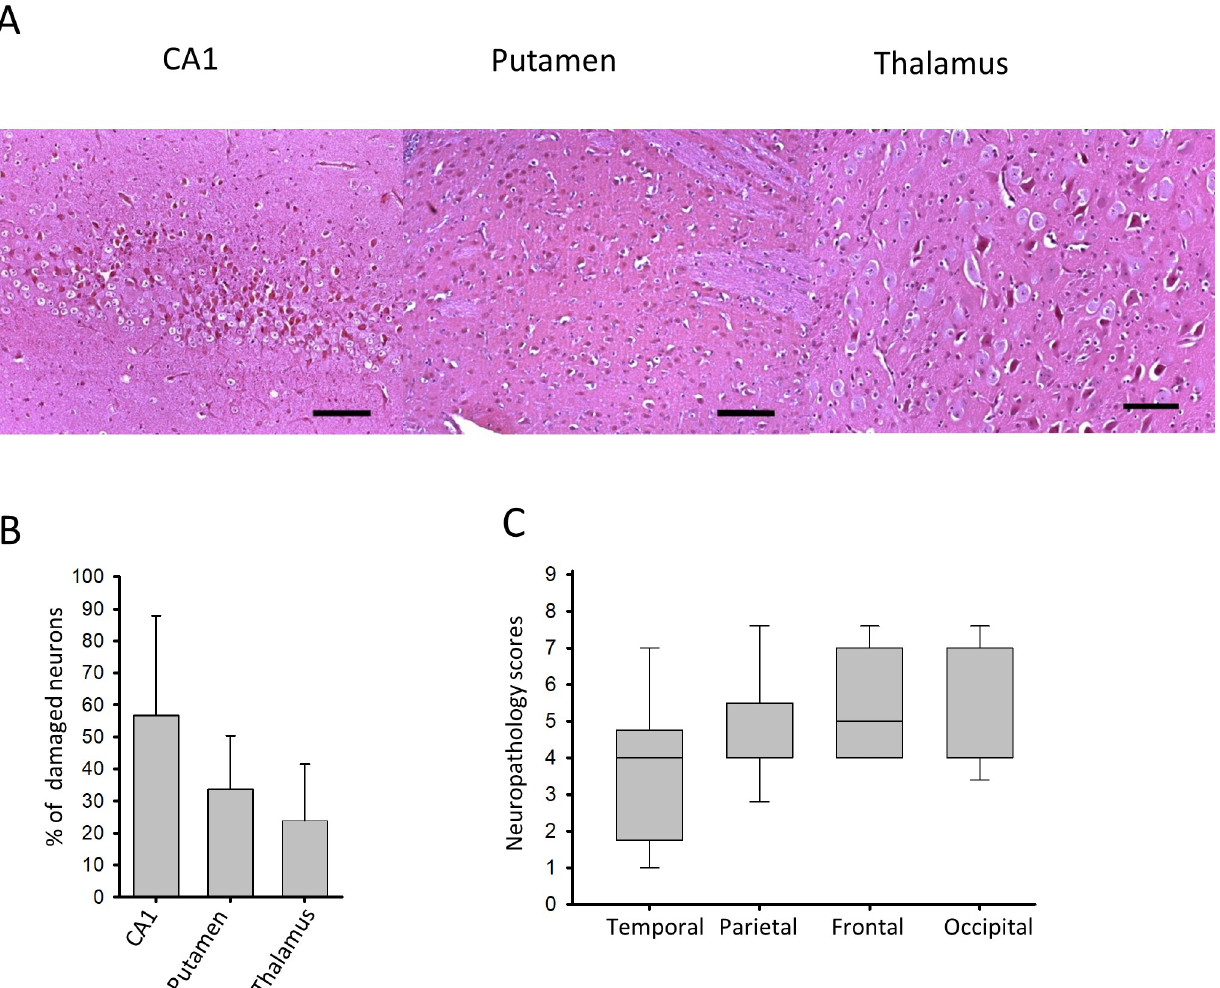
Fig 4. Neuronal injury evaluated at 24 hours after PA. (A) Representative photomicrographs showing injured red neurons at 24-hours of after asphyxia in the CA1 hippocampal region, the putamen, and the thalamus (scale bar: 100 μ m) (B) Cell counting revealed moderate neuronal damage in these regions (n = 8, mean ± SEM). (C) Asphyxia also induced moderate/severe neocortical damage shown by medium/high neuropathology scores (lines, boxes, and whiskers represent the median, the 25 th -75 th , and the 5 th -95 th percentiles, respectively).